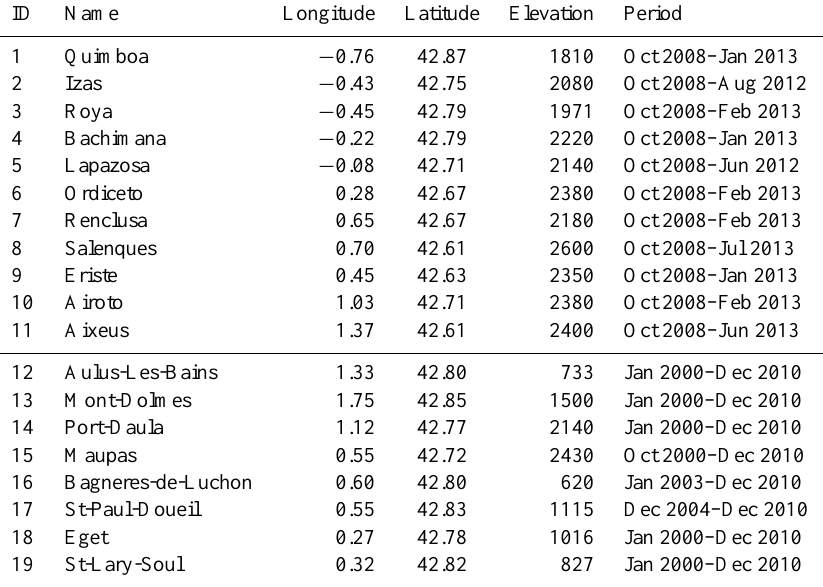
Table 1. Description of the in situ snow data used in this study. Stations 1–11 are telenivometers from the ERHIN program for which daily data of snow depth and snow water equivalent were available. Stations 12–19 are Météo-France stations for which daily data of snow depth only were available. Longitude and latitude are given in decimal degrees (WGS84) and elevation in meters a.s.l. ID Name Longitude